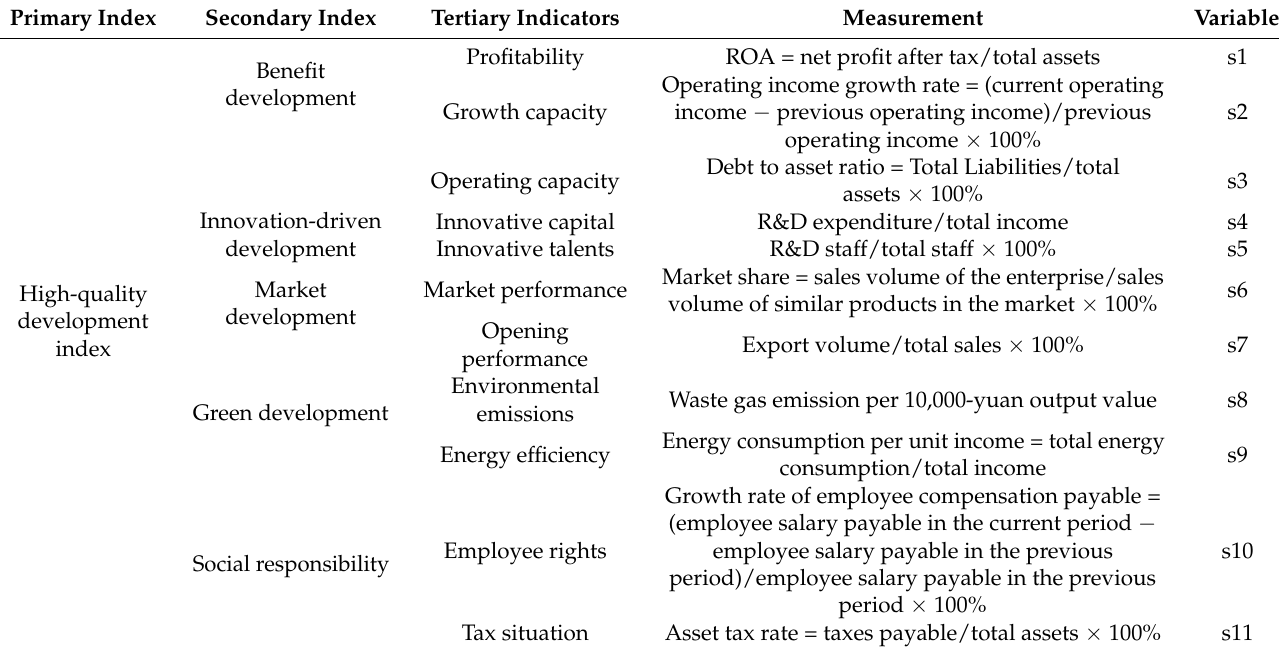
Table 1. Three levels of